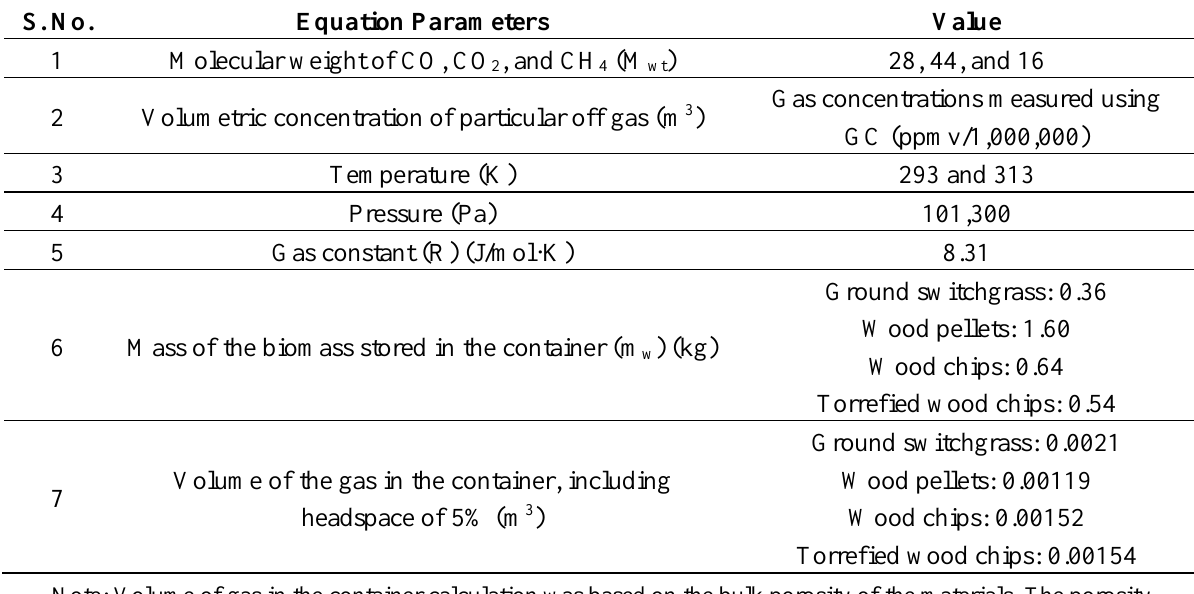
Table 1. Constants used for emission factor (g/kg) calculation based on off-gas concentration